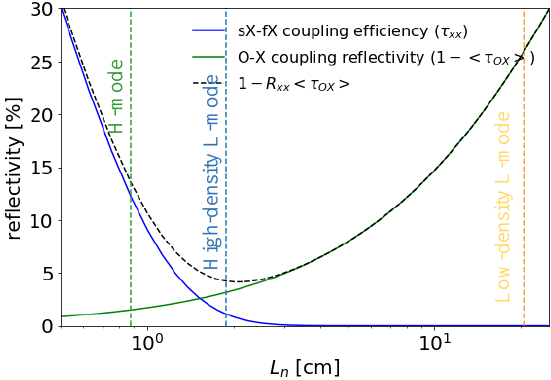
Fig. 12 : The analytical reflectivity as a function of scale length for MAST Upgrade parameters. Dashed vertical lines represent the expected scale lengths at the cut-off position for 34.8 GHz in H-mode, high-density, and low-density L-modes.